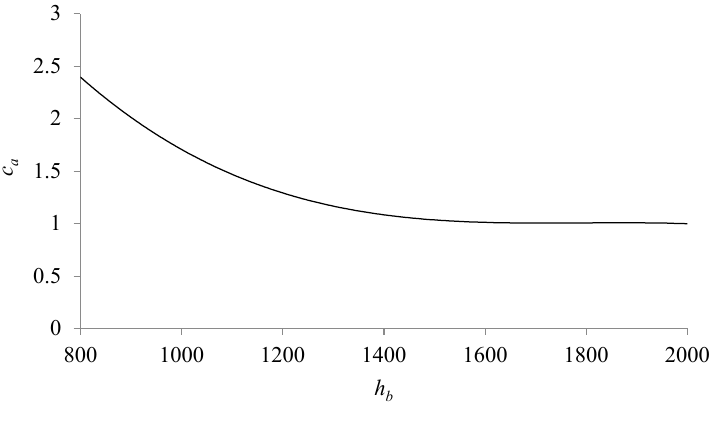
Figure 5. Correction function c a.